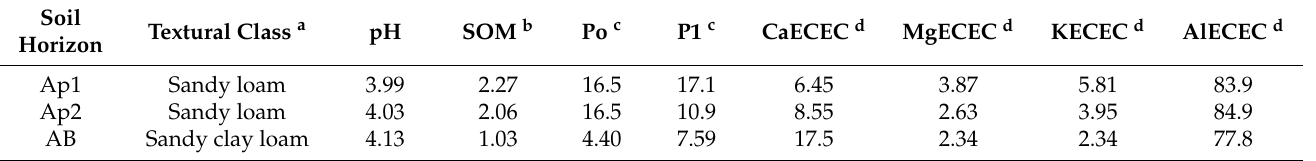
Table 1. Baseline soil horizon characteristics before liming for Ap1 (0–12 cm), Ap2 (12–25 cm) and AB (25–35 cm) horizons ( n =